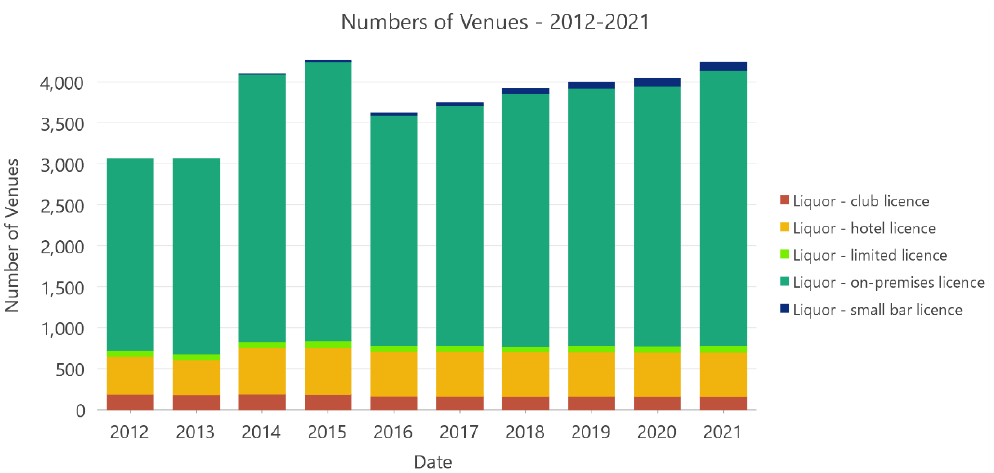
Figure 20. Number of venues by type for the entire study area 2012–2021.